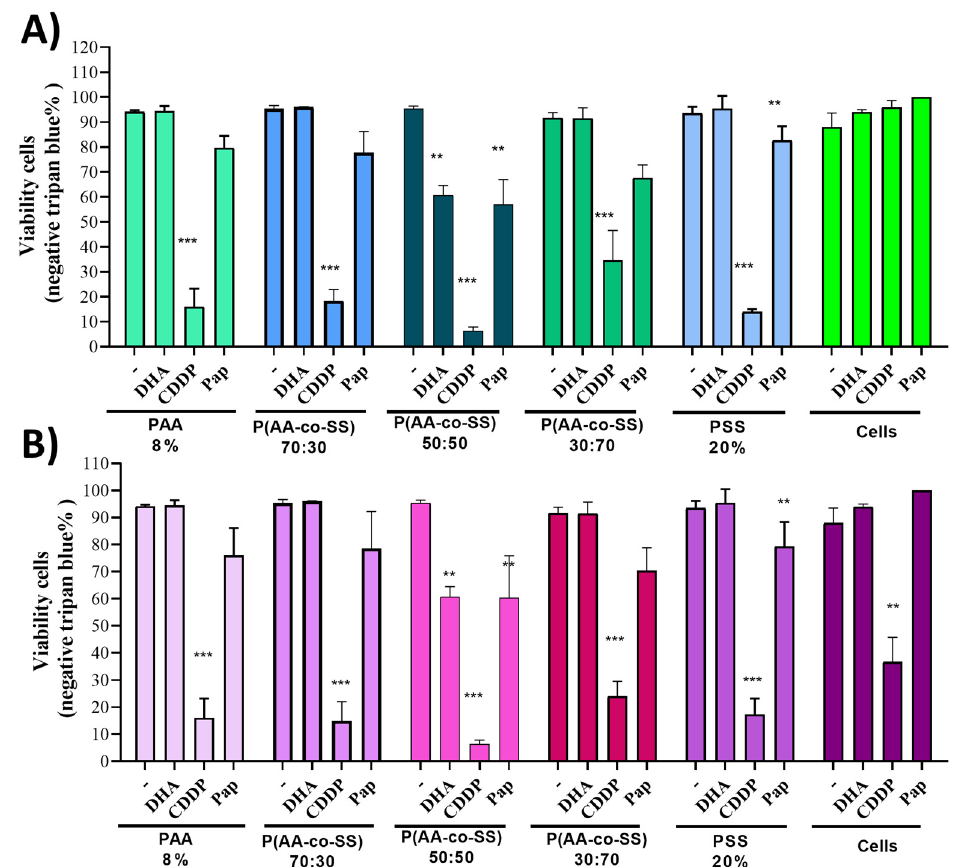
Figure 7. Cell viability of gastric tumoral cells AGS and breast cancer metastatic MDA-MB-231 in the presence of EPnF meshes charged with drugs. The cells ( A ) AGS tumoral gastric and ( B ) MDA-MB-231 breast cancer cells, were harvested in plate pre incorporated the different drugs charged meshes. After 24 or 48 h post-harvested, the total cell number and viability were determined by Trypan blue (Tb) as previously described [33,45].